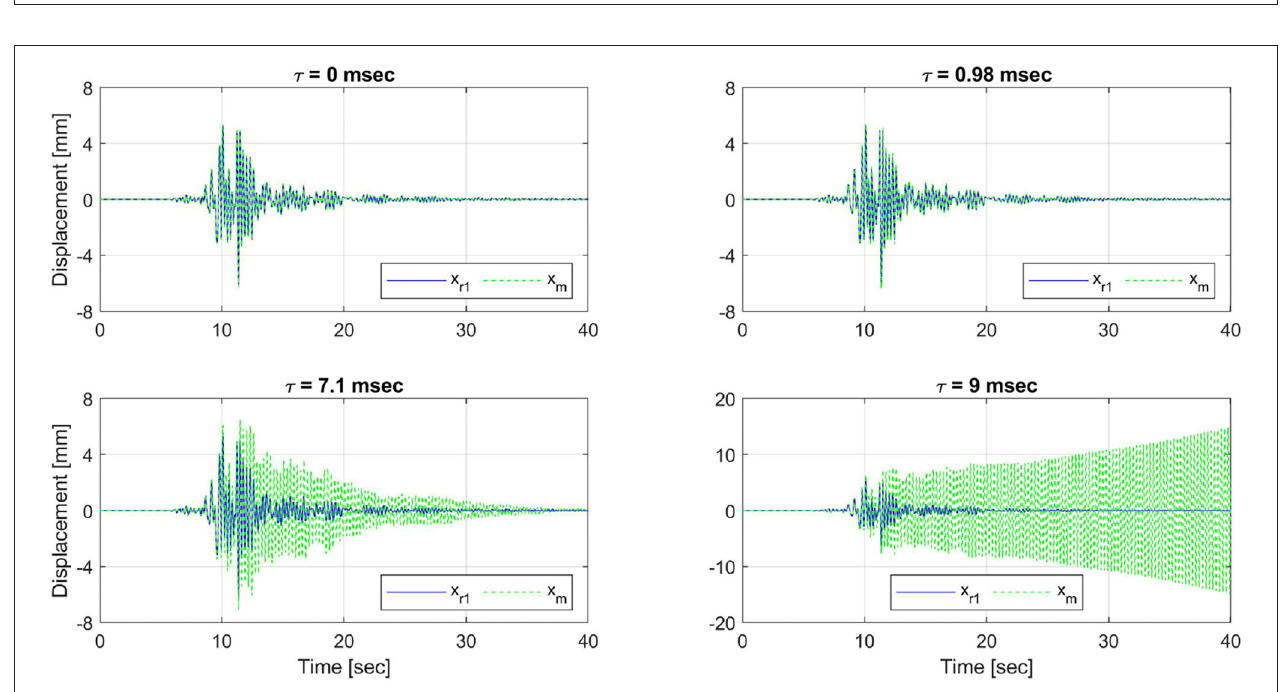
FIGURE 5 | Reference and measured displacements for different delay